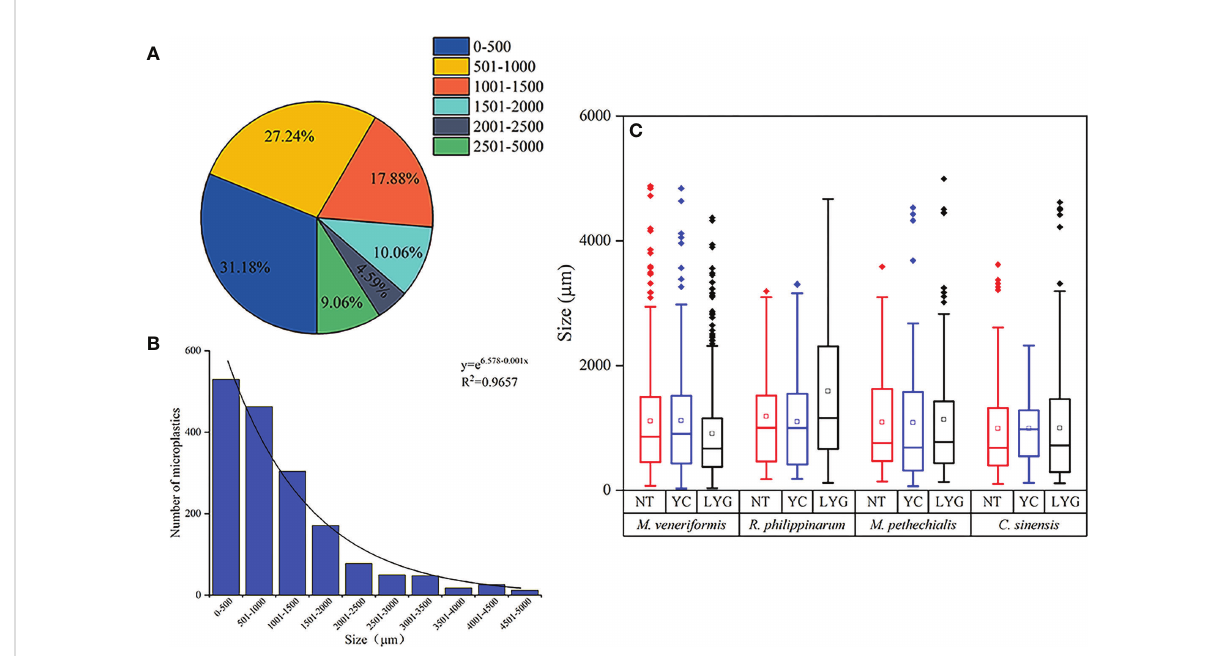
FIGURE 5 Particle size distribution of MPs identi fi ed in all clam samples (A, B) and four species from three intertidal zone (C) of South Yellow